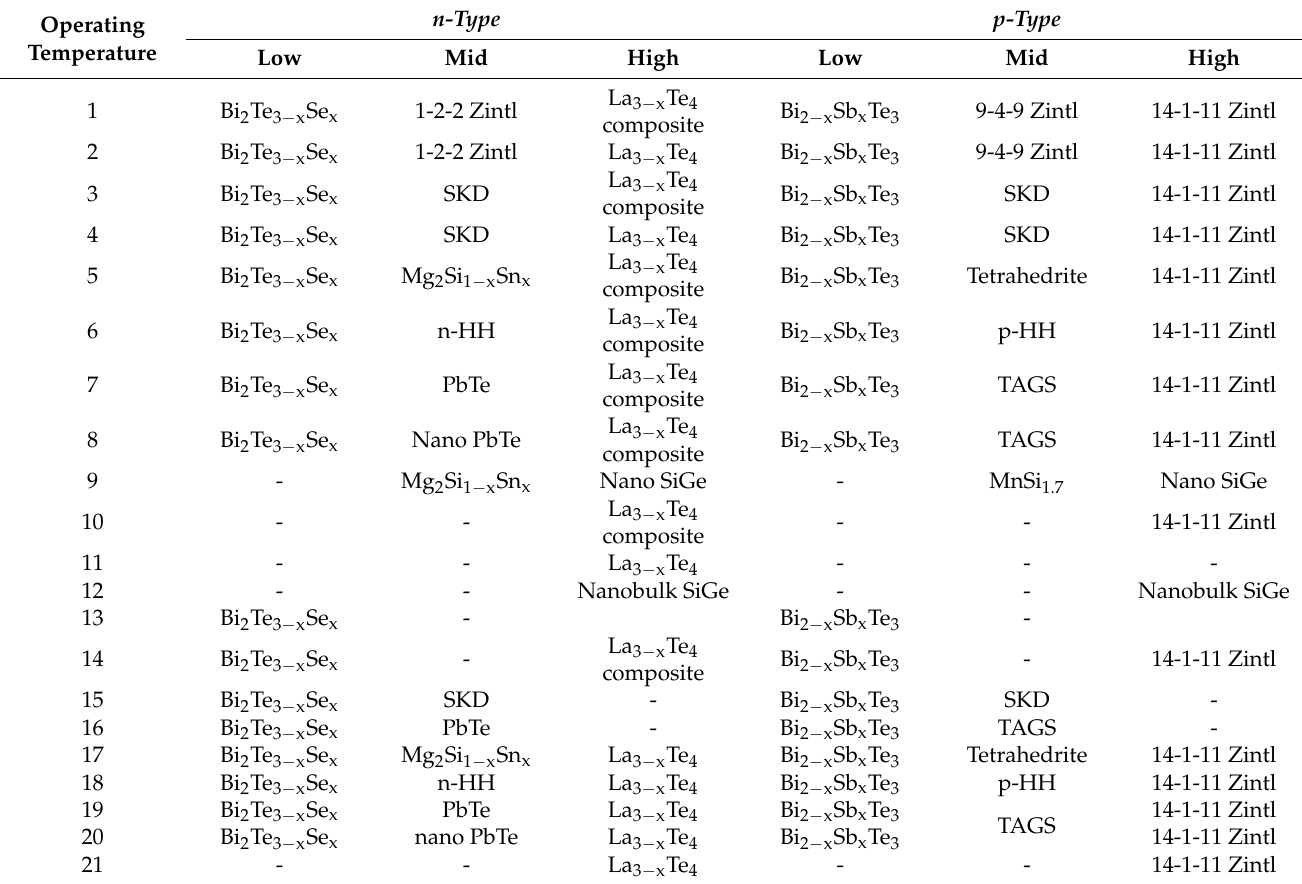
Table 2. p-Type and n-type thermoelectrics used for low, mid, and high temperatures. Repro- duced with permission from “NASA Special Session: Next-Generation Radioisotope Thermoelectric Generator (RTG) Discussion” from the National Aeronautics and Space Administration, 2017